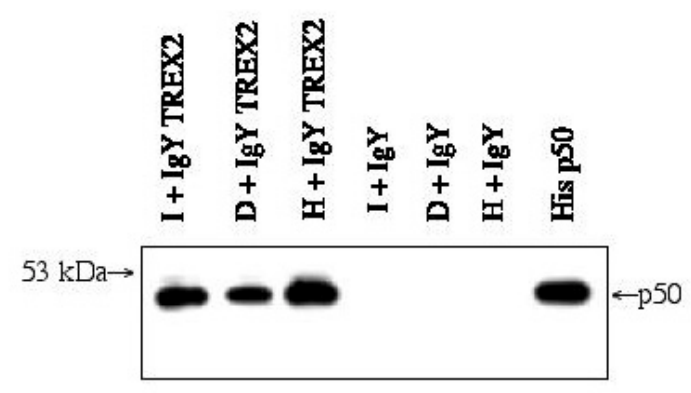
FIGURE 2. The TREX2 3 ′→ 5 ′ exonuclease physically interacts with pol δ . I, D (see Fig. 1B) and human (cell line Mg63, osteosarcoma) total cell extract (H) were immunoprecipitated with anti-TREX2 polyclonal antibody (IgY TREX2), or with chicken preimmune IgY as a control, and were analyzed by Western blot with rat monoclonal antibody against the small subunit of pol δ (p50). For this, a 12% SDS-PAGE and nitrocellulose membrane was used.